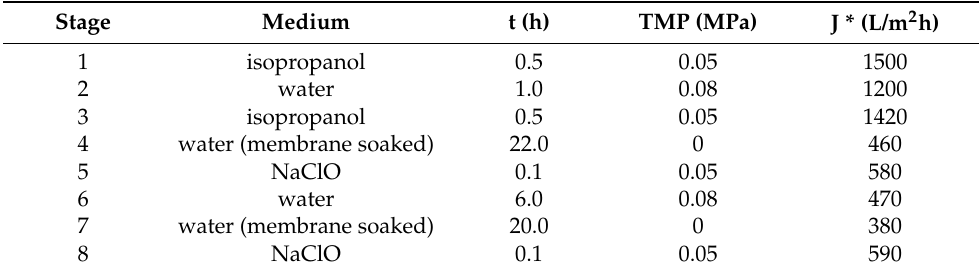
Table 2. Procedure of membrane